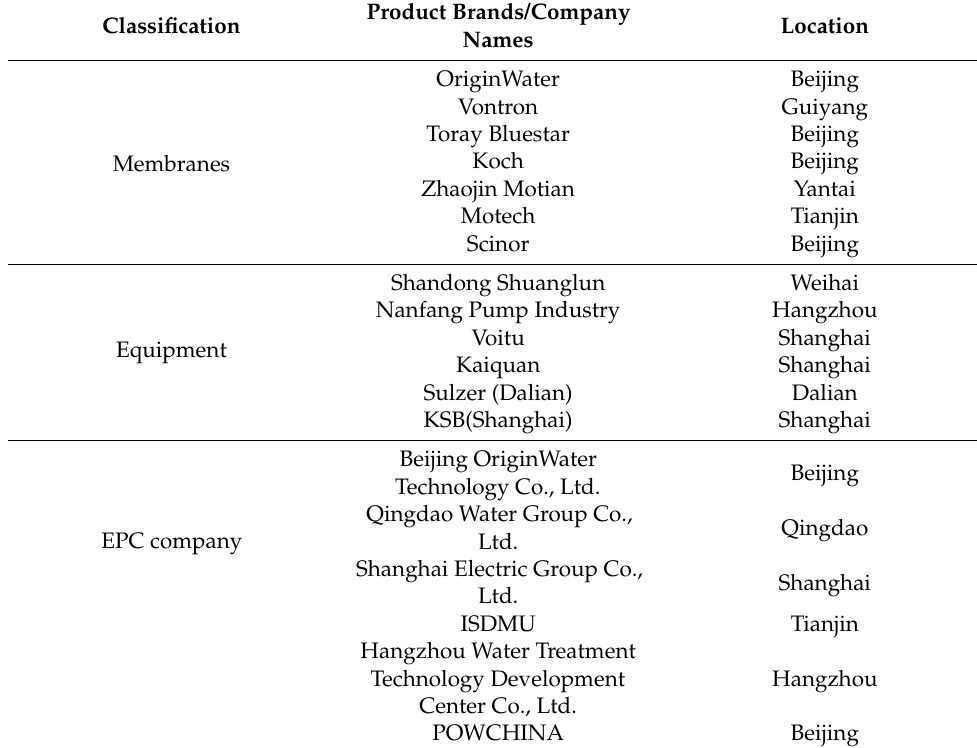
Table 1. Main products and EPC companies in